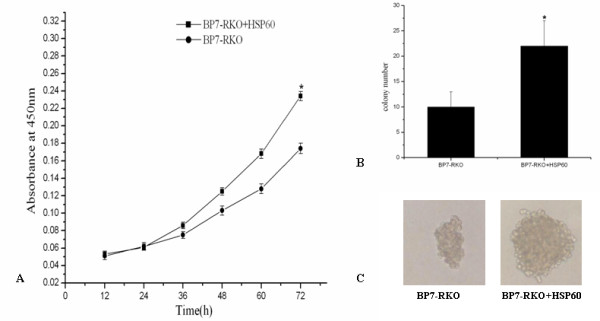
HSP60 protein decreased the proliferation rate and colony formation ability of PcDNA3.1(IGFBP7)-RKO cells. A: PcDNA3.1(IGFBP7)-RKO cells were plated in sextuple in 96-well microtitre plates at 3 × 103/well, cultured with medium with or without recombinant HSP60(1 μg/ml). Ten μl of CCK8 was added to each well at the indicated time (12 h, 24 h, 36 h, 48 h, 60 h, 72 h). Cellular viability was determined by measuring the absorbance of the converted dye at 450 nm two hours after adding CCK8. Values shown are mean ± SD for sextuple cultures from one experiment, representive of three independent experiments conducted. B: PcDNA3.1(IGFBP7)-RKO cells (500/well) were seeded into 0.3% Bacto-agar over a 0.6% agar bottom layer in triplicate in 6-well plates, with or without 1 μg/ml HSP60. After 3 weeks of incubation, colony number (>100 μm)were analyzed. Values are mean ± S.D for data from three independent experiments. C: Colony size was also analyzed under microscopy. Representive size of the colony was photographed under high power microscopy (×100).